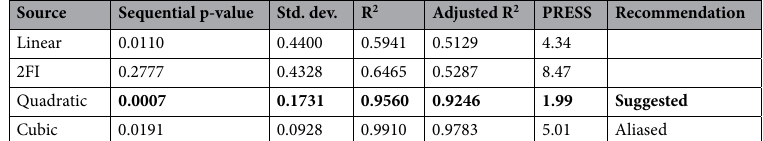
Source Sequential p-value Std. dev. R 2